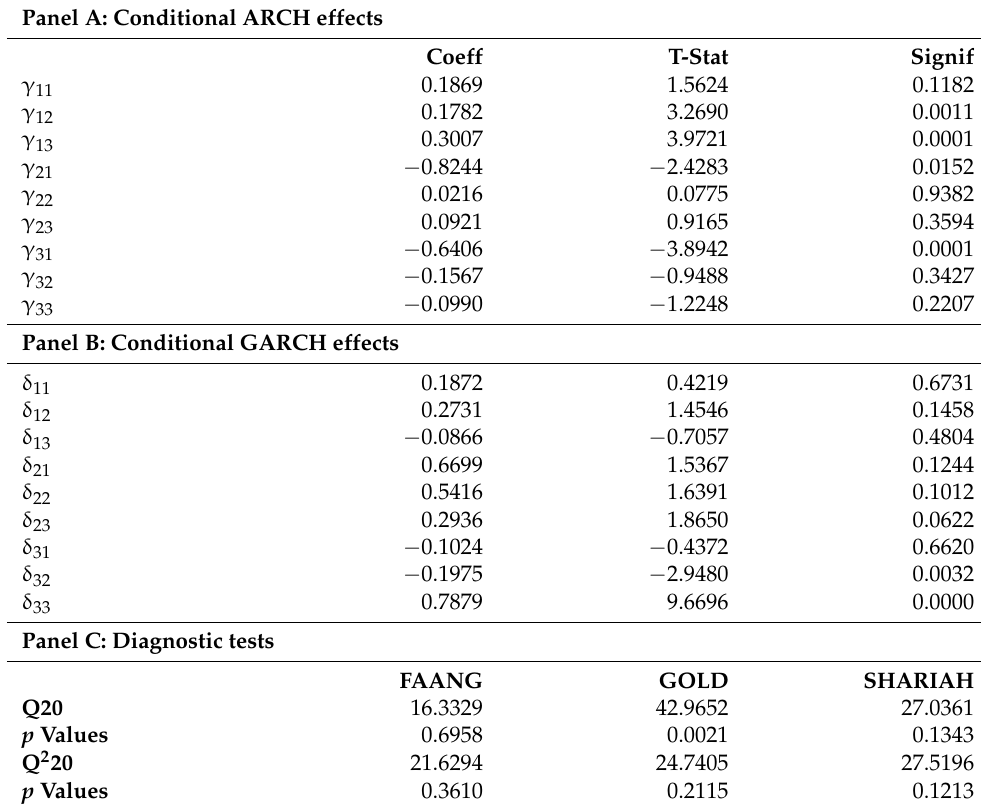
Table 2. GARCH–BEKK parameter estimates of volatility spillovers among FAANG stocks, gold, and sharia-compliant